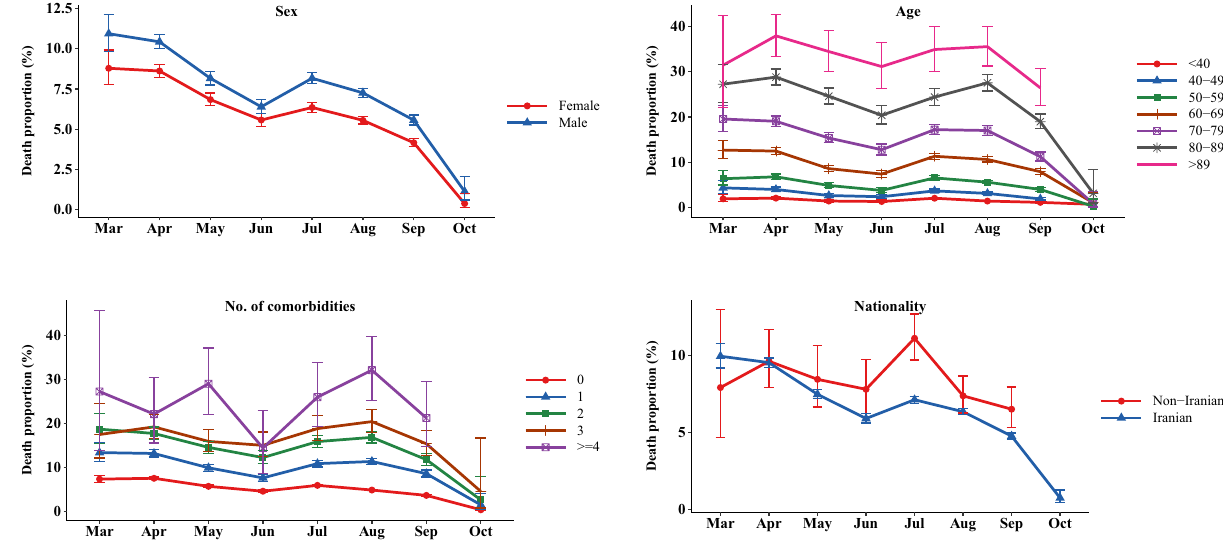
Figure 5. The death proportion and 95% confidence interval due to COVID-19 among hospitalized patients by sex, age, no. of comorbidities, and